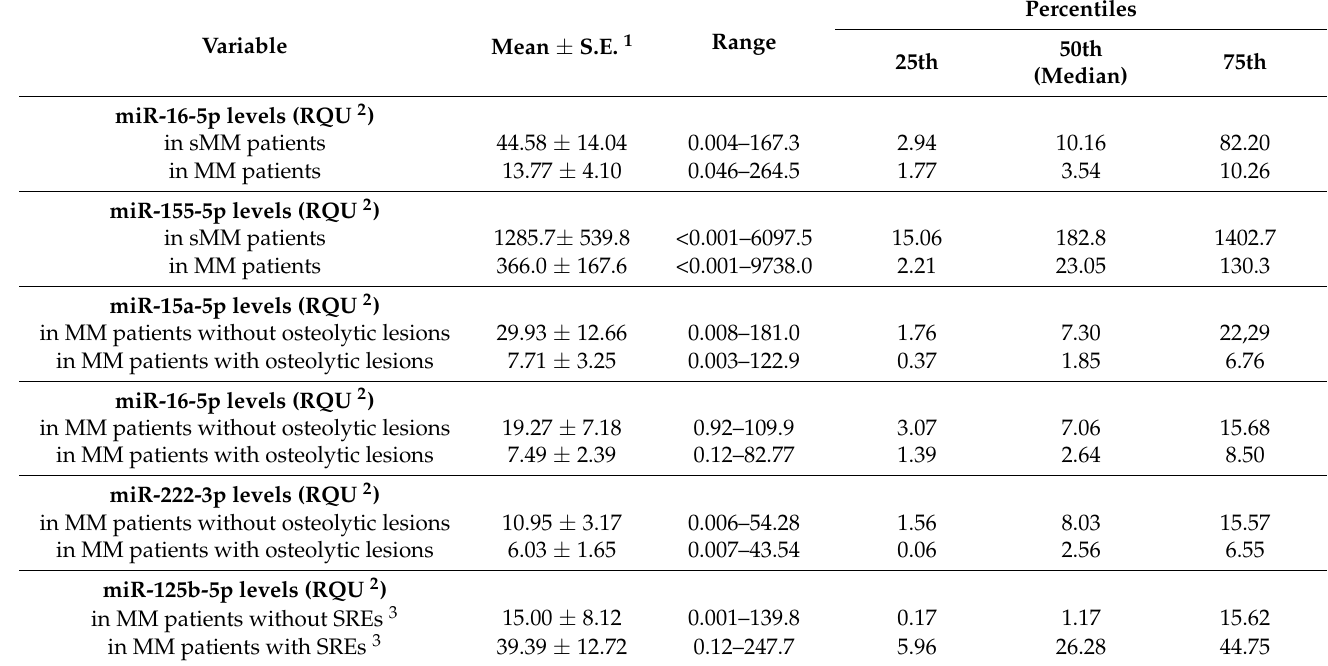
Variable Mean ± S.E. 1 Range